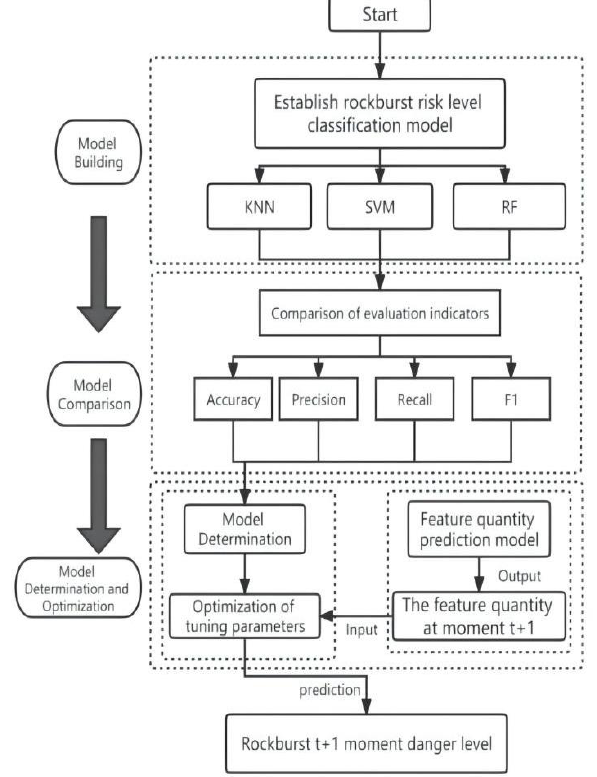
Figure 7. Rockburst risk level classification model building process.